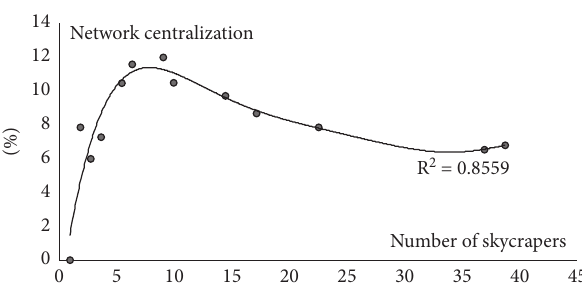
Figure 6: The relationship between centralisation index and the number of skyscrapers.